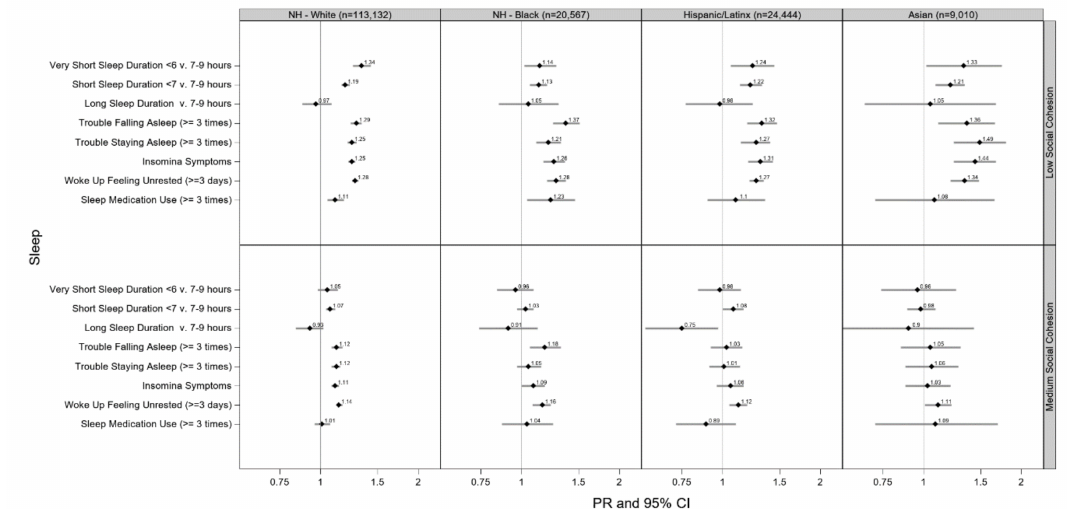
Figure 3. Adjusted prevalence ratios of sleep health by low and medium compared to high neighborhood social cohesion among U.S. racial / ethnic adults, National Health Interview Survey, 2013–2018 (N = 167,153). Race / ethnic-specific model adjusted for age (18–30, 31–49, 50 + years), sex / gender (women or men), educational attainment ( < high school, high school graduate, some college, ≥ college), annual household income ( < $35,000, $35,000–$74,999, $75,000 + ), occupational class (professional / management, support services, laborers), region of residence (Northeast, Midwest, South, West), alcohol consumption (never, former, current), serious mental illness (Kessler-6 psychological distress scale score ≥ 13), “ideal” cardiovascular health (never smoking / quit > 12 months prior to interview, BMI 18.5 to < 25 kg / m 2 , meeting physical activity guidelines, and no prior diagnosis of dyslipidemia, hypertension, or diabetes / prediabetes), marital / co-habiting status (married / living with partner or cohabitating, divorced / widowed / separated, single / no live-in partner), employment status (unemployed, employed), and health status (excellent / very good, good, fair / poor). Reference level: high neighborhood cohesion. Note. All estimates are weighted for the survey’s complex sampling design. Insomnia symptoms defined as either trouble falling asleep and / or di ffi culty maintaining sleep 3 + times a week.